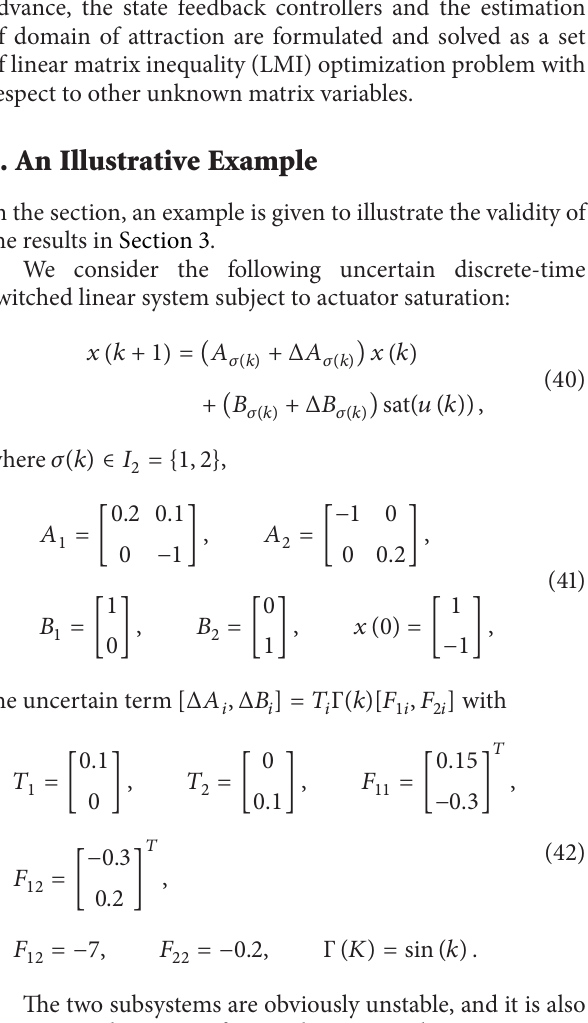
Figure 1: The state response of subsystem